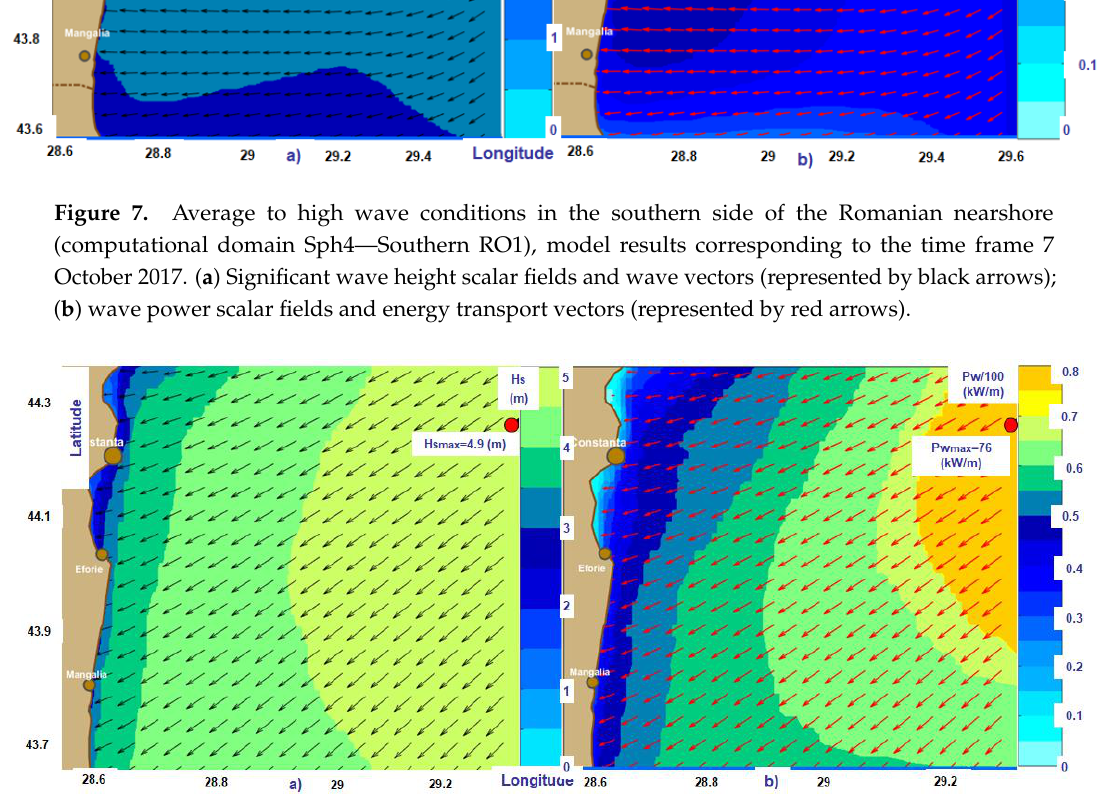
Figure 8. High wave conditions in the southern side of the Romanian nearshore (computational domain Sph5—Southern RO2), model results corresponding to the time frame 25 October 2017. ( a ) Significant wave height scalar fields and wave vectors (represented by black arrows); ( b ) wave power scalar fields and energy transport vectors (represented by red arrows).